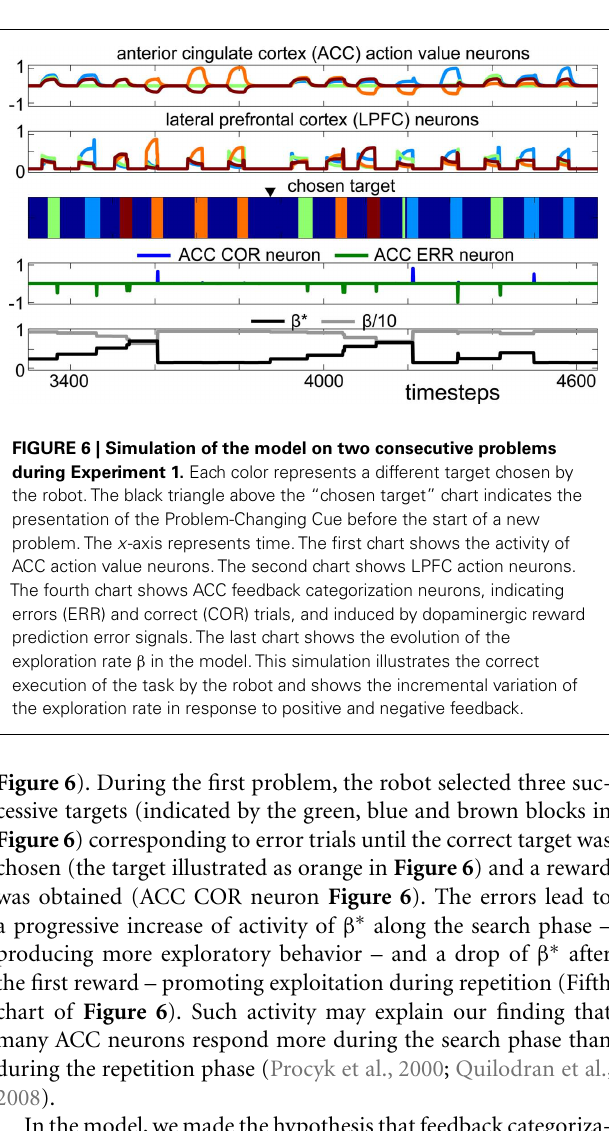
Figure 6 ). During the first problem, the robot selected three suc- cessive targets (indicated by the green, blue and brown blocks in Figure 6 ) corresponding to error trials until the correct target was chosen (the target illustrated as orange in Figure 6 ) and a reward was obtained (ACC COR neuron Figure 6 ). The errors lead